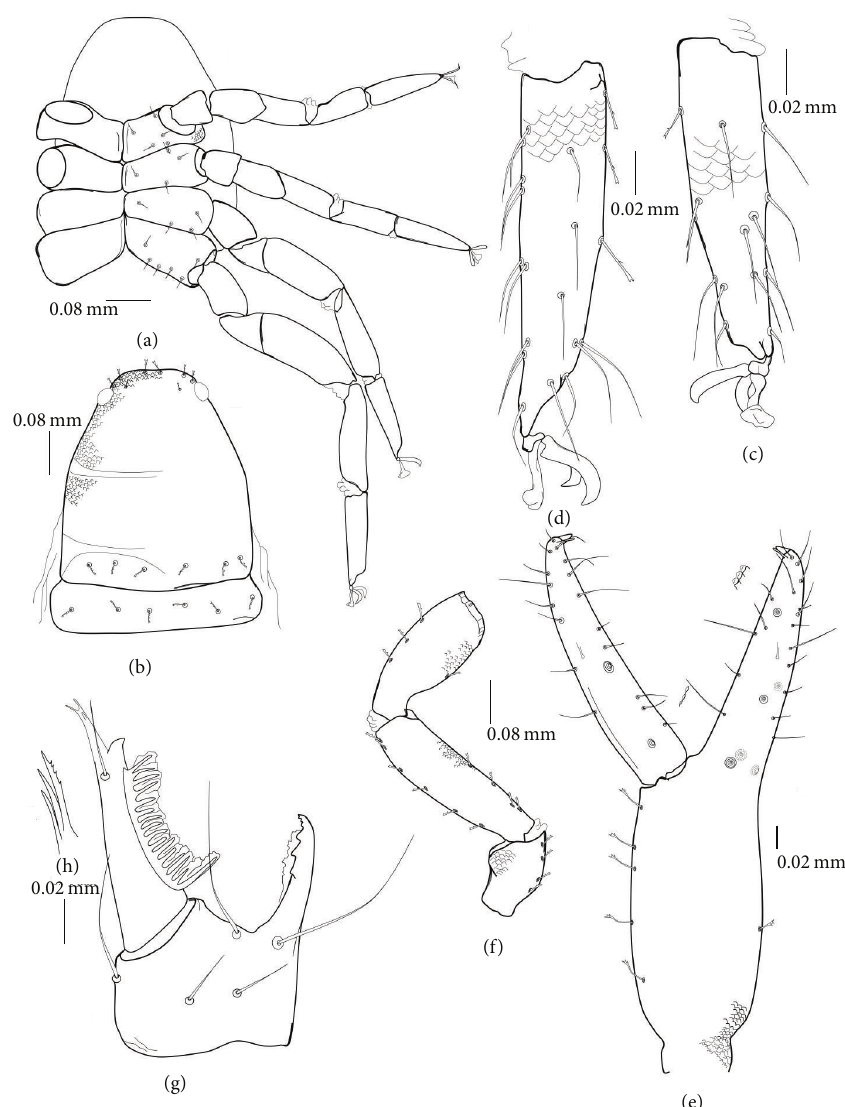
Figure 4: Deutonymph: (a) legs and ventral view of carapace, (b) dorsal side of carapace, (c) tarsus of leg I, (d) tarsus of leg IV, (e) left chela, (f) pedipalp, (g) chelicera, and (h)